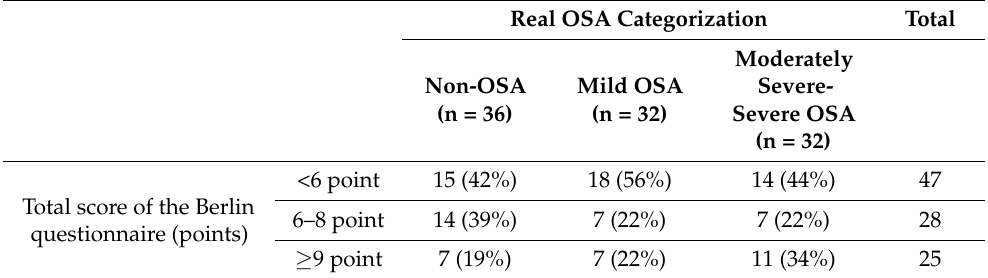
Table 2. Distribution of Berlin questionnaire scores by OSA severity subgroups (the table shows the number of cases per 100 patients and the percentage distribution of scores within each OSA category). OSA: obstructive sleep apnoea.